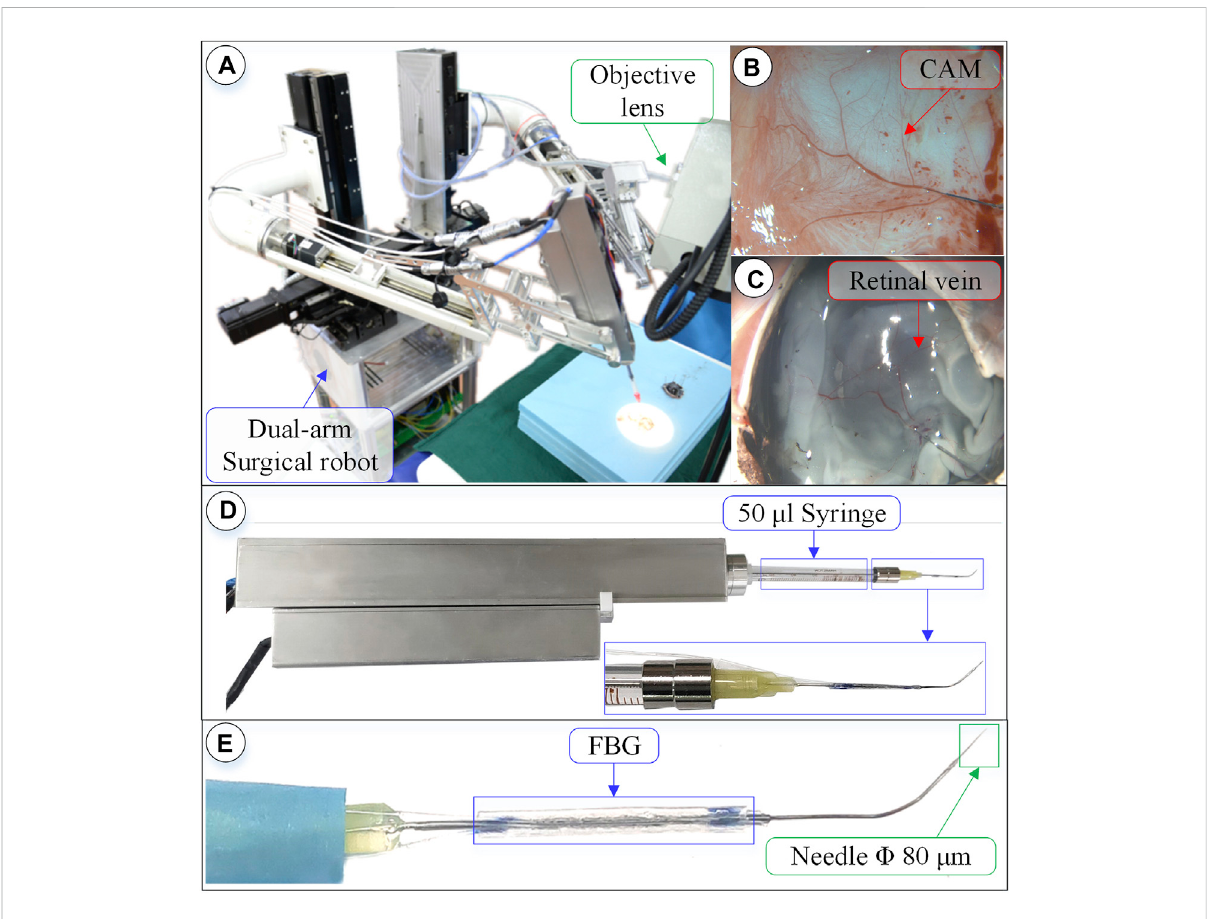
FIGURE 7 Surgical robot system under microscopic image. (A) Dual-arm robot under microscope. (B) CAM blood vessel. (C) Isolated pig eyeball retinal vein. (D) 3-DOF micro-force-sensing injection device. (E) Three-dimensional micro-force-sensing injection